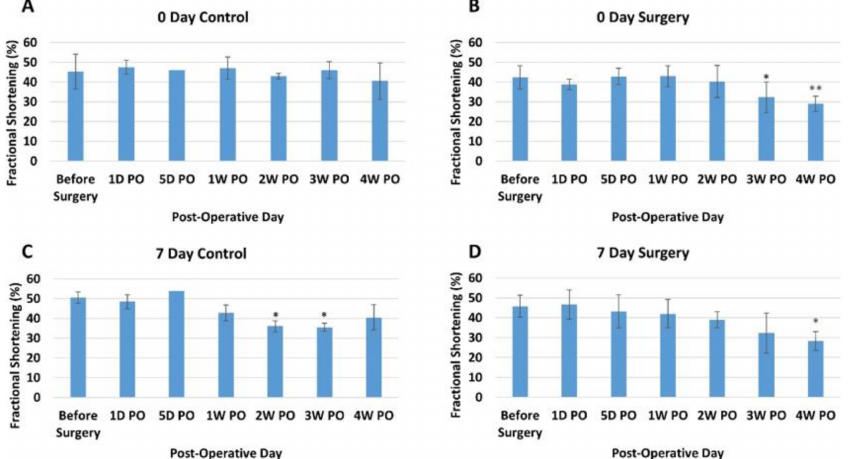
Figure 3. Average fractional shortening (percentage) at different time points for each group. ( A ) Zero- day control group. ( B ) Zero-day surgery group. ( C ) Seven-day control group. ( D ) Seven-day surgery group. * and ** represent a significant difference ( p < 0.05) between before surgery and the labeled time